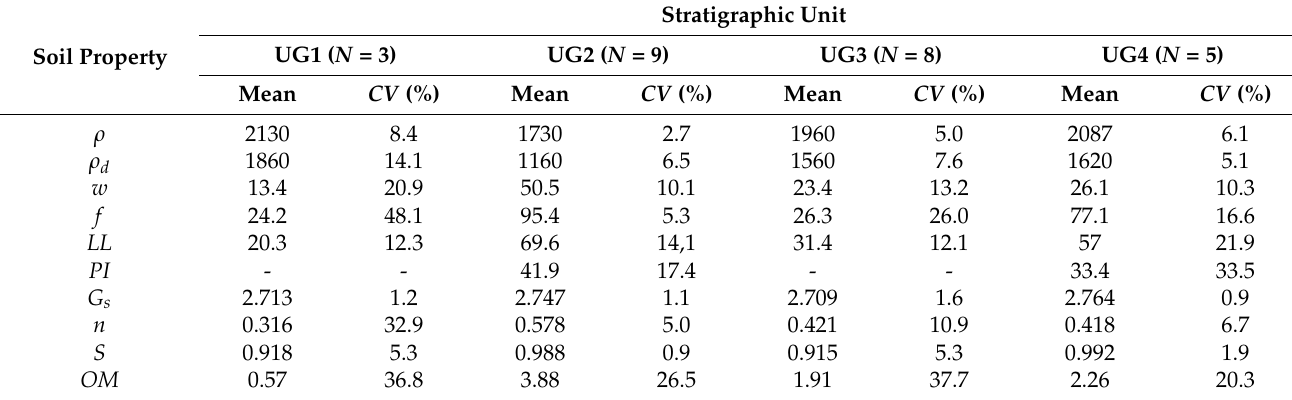
Table 2. Descriptive statistics of index properties of the soil samples a